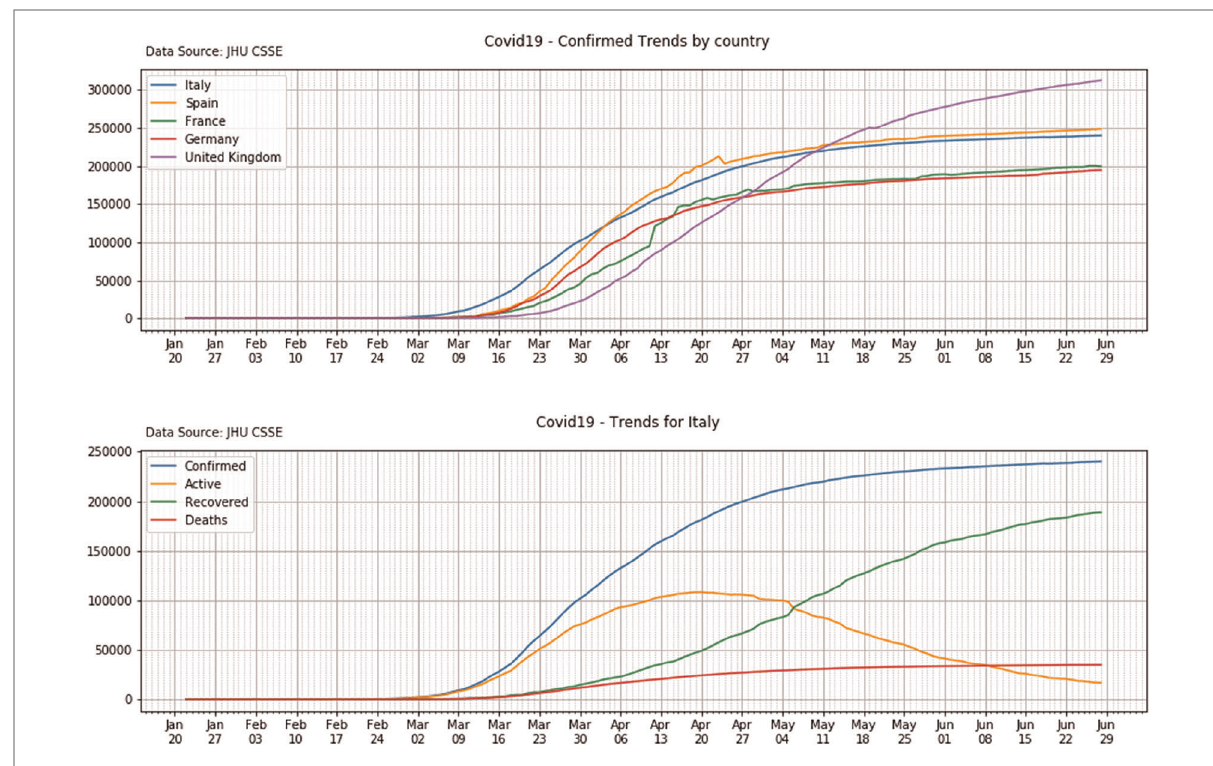
FIGURE 1 Top panel: the trends of the con fi rmed cases for the fi ve countries in scope. Bottom panel: the Con fi rmed, Active, Recovered and Deaths values for a single country: